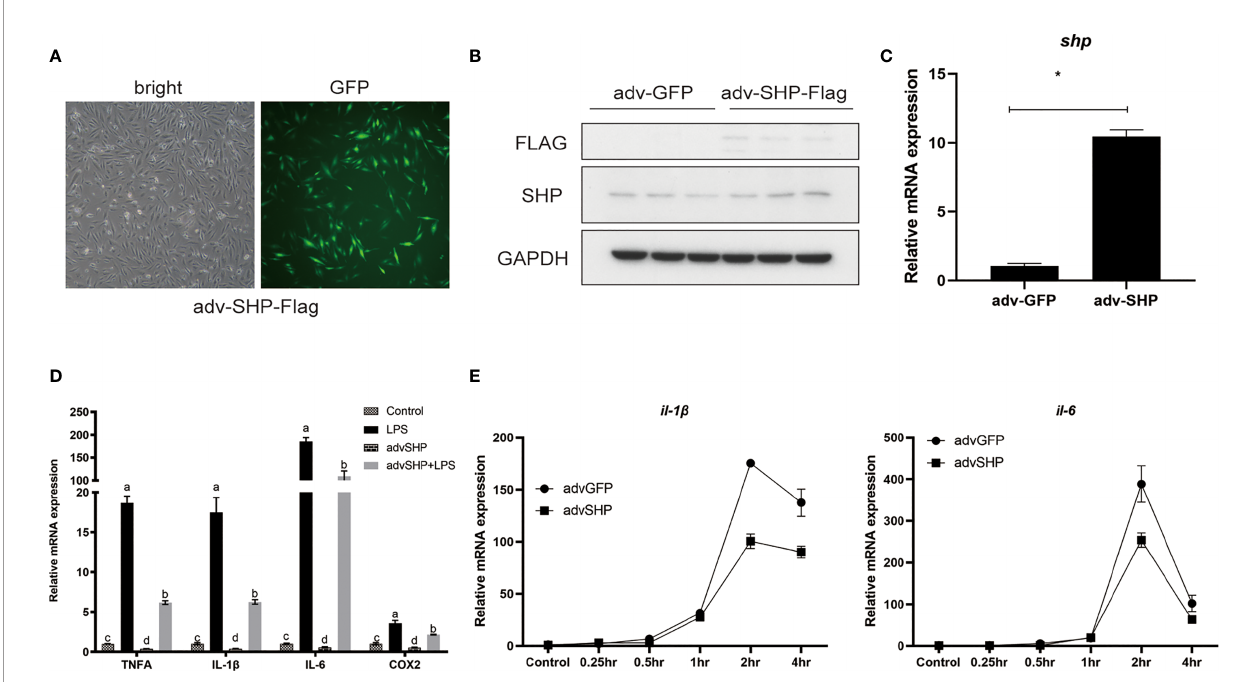
FIGURE 7 | Effects of SHP on LPS-induced in fl ammation of large yellow croakers. (A-C) Fluorescence analysis, immunoblots and qRT-PCR assays for SHP in macrophages infected by croaker SHP adenovirus. (D) Expression of tnf a , il-1 b , il-6 and cox2 in macrophages after LPS stimulation alone or with SHP overexpression. (E) Expression of il-1 b and il-6 in macrophages after LPS stimulation at different time points. Data are presented as means ± SEMs, n = 3 replicate experiments. Signi fi cance was evaluated by one-factor ANOVA followed by Duncan ’ s multiple range test. Labeled means without a common letter differ, P < 0.05. ∗ Different from control (adv-GFP), P < 0.05 (Student ’ s t -test). cox2 , cyclooxygenase 2; LPS, lipopolysaccharide; il-1 b , interleukin 1 beta; il6 , interleukin 6; SHP, small heterodimer partner; GAPDH, glyceraldehyde-3-phosphate dehydrogenase; tnfa , tumor necrosis factor